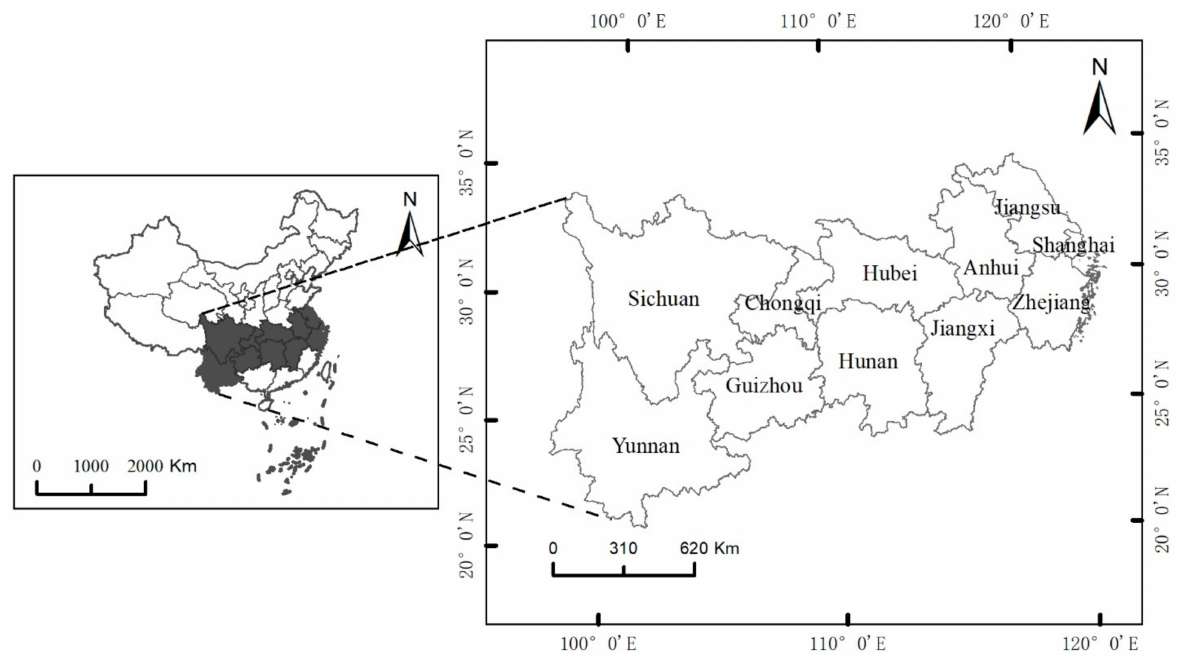
Figure 2. Location map of the Yangtze River Economic